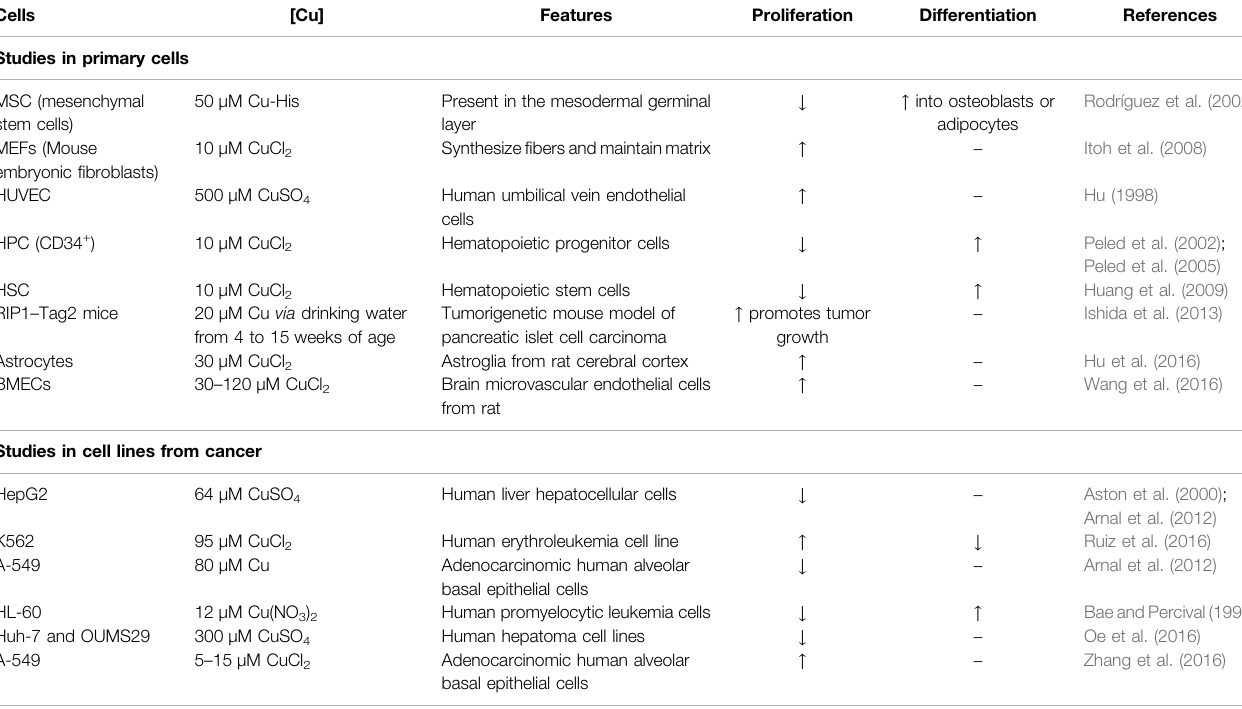
TABLE 2 | Effect of copper increase on proliferation and differentiation in different cell